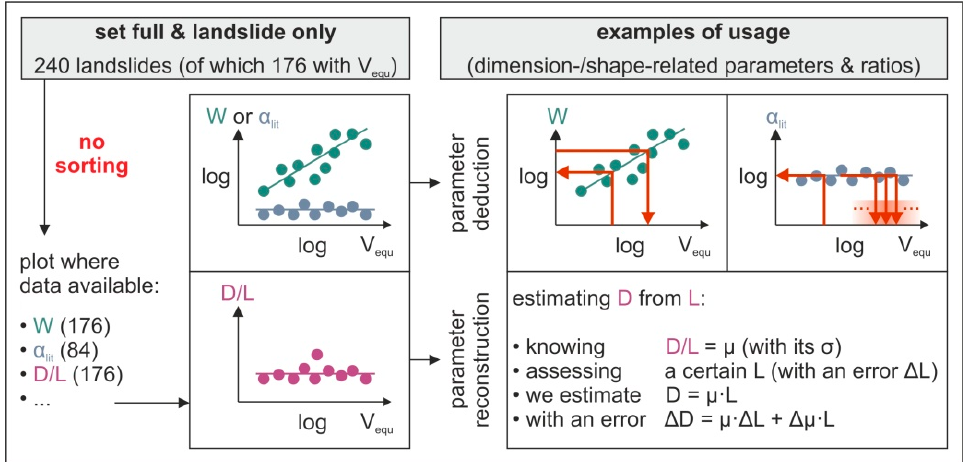
Figure 6. Schematic representation of the statistical approach. Landslides of a particular set are screened for showing a calculated volume (V equ ). Those that also show a variable of correlation (e.g., maximum depth (D), reported slope angle ( α lit ), or the ratio of the maximum width and the length along the slope (W/L)) are then used for plots that illustrate the respective correlation. The right part of the figure shows examples of usage of the established correlations.